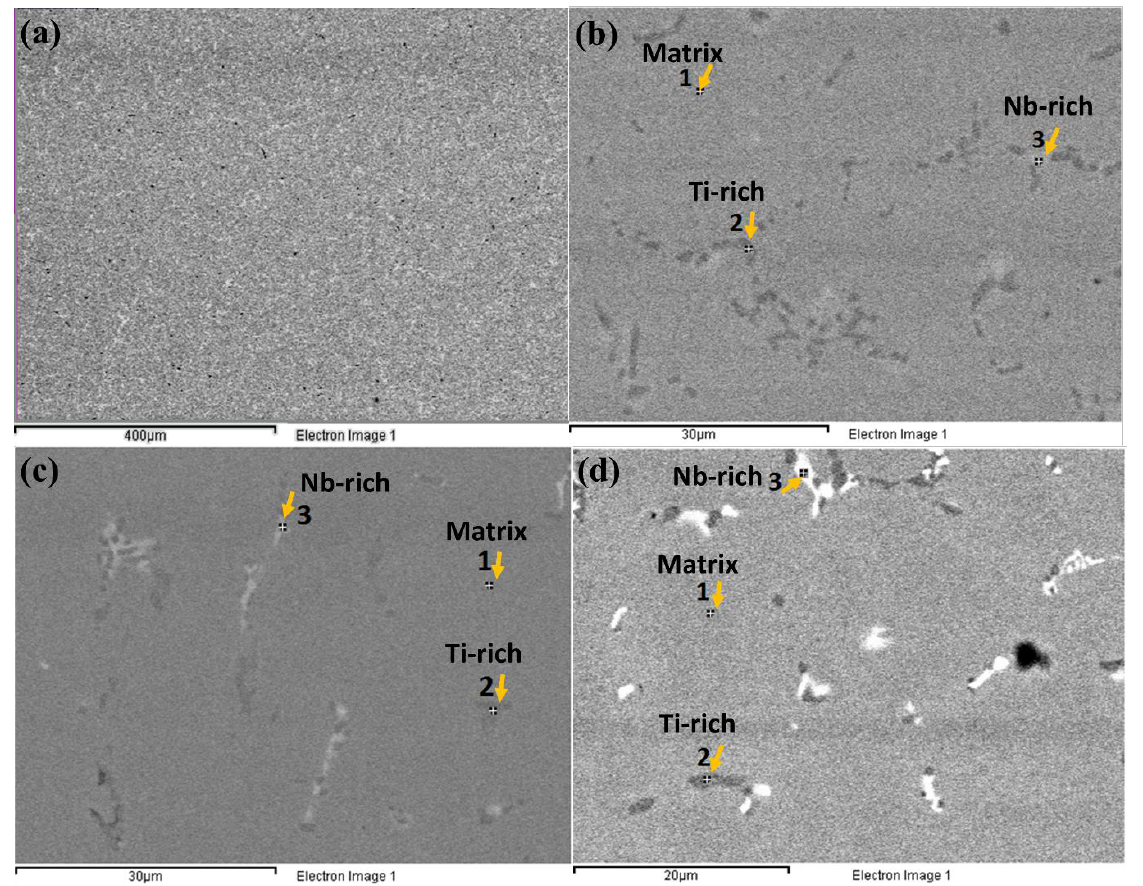
Figure 5. Backscatter images of Ti 51 − 0.5X Ni 39 − 0.5X Cu 10 Nb X sample produced by SDA show: ( a ) fine precipitates in Ti 49.5 Ni 37.5 Cu 10 Nb 3 sample under low magnification; ( b ) dark contrast Ti-rich precipitates and a few bright contrast Nb-rich particles within the 1 at.% Nb sample; ( c ) both dark and bright contrast precipitates (Ti-rich and Nb-rich) within the 2 at.% Nb sample; ( d ) more bright contrast Nb-rich particles around 2 to 3 µm size within the 3 at.% Nb sample.